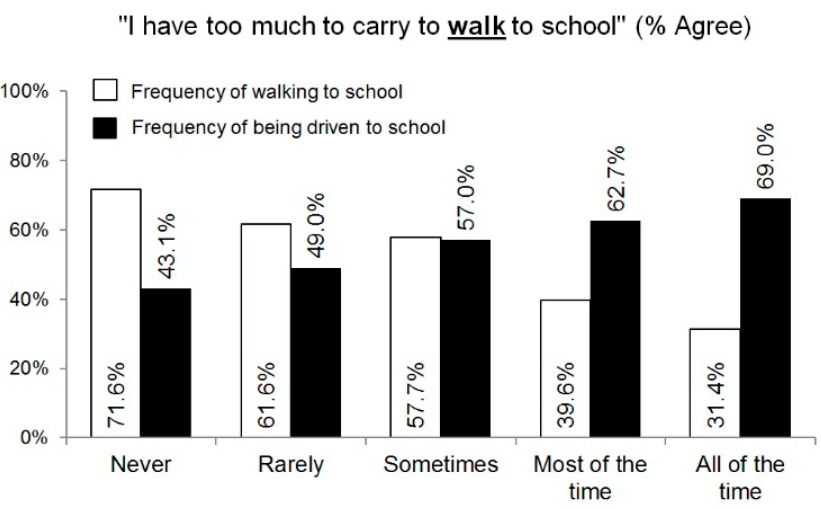
Figure 3. Adolescents’ agreement with the statement that they carry too much to walk to school by frequency of walking and being driven to school.